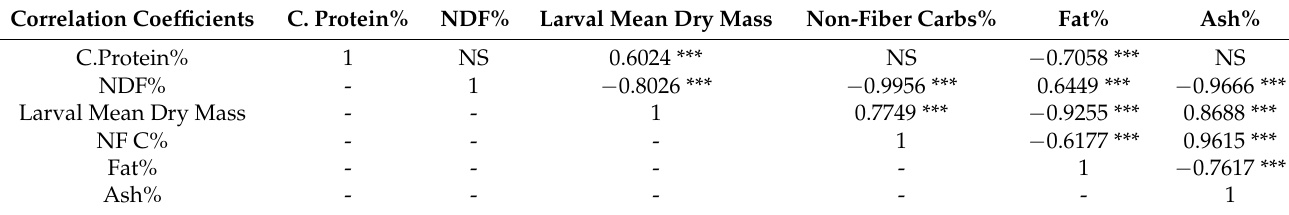
Table 6. Pearson correlation coefficients between nutritional parameters and mean larval dry mass